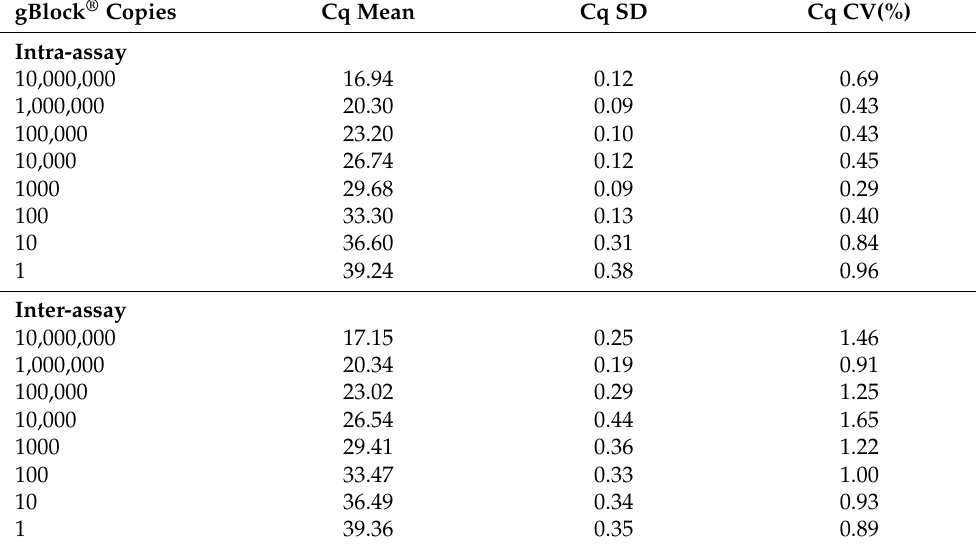
Table 2. Repeatability of Yokenella qPCR assay targeting pheS gene. Table shows the mean, standard deviation ( SD ) and coefficient of variation (CV) of the cycle threshold (Cq) values. Amplification of serially diluted gBlock ® , ranging from 10 7 copies to 1 gene copy reaction − 1 . To determine intra-assay variation, eight replicates were conducted on a single plate. Eight replicates were conducted on a subsequent plate for determination of the inter-assay variation.